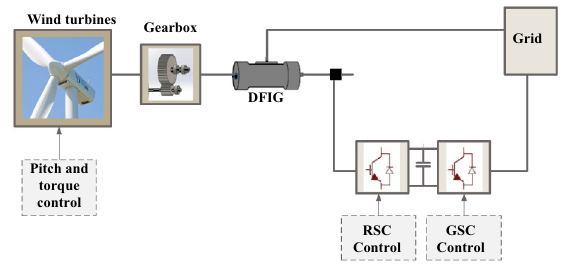
Fig. 1 DFIG electric